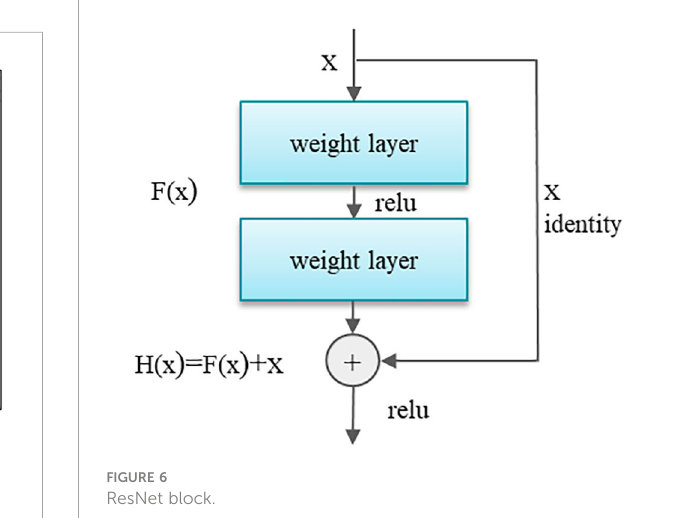
FIGURE 6 ResNet block.